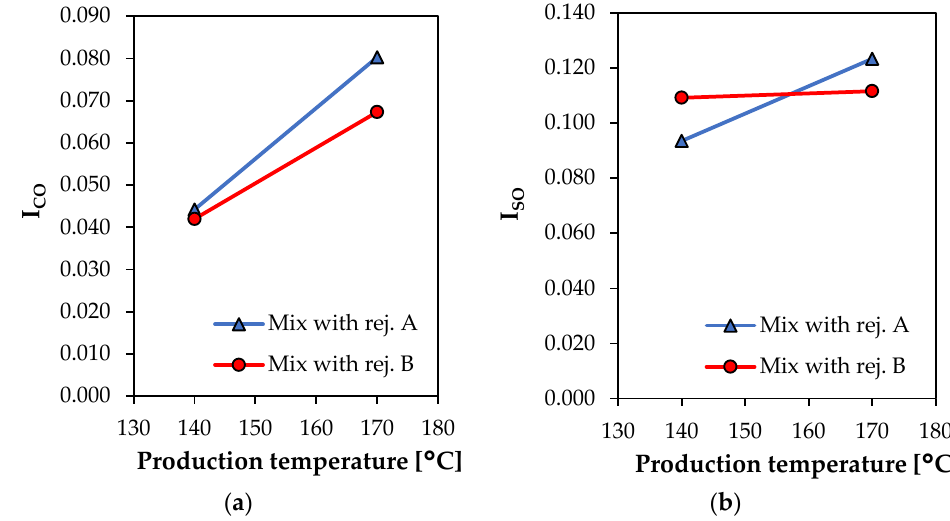
Figure 7. Oxidation indexes from FTIR analysis: ( a ) Carbonyl index I CO ; ( b ) Sulfoxide index I SO .